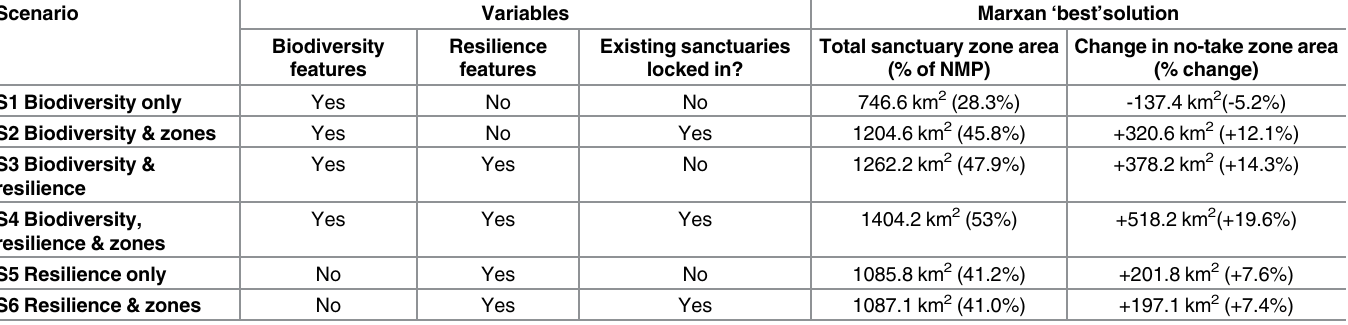
Table 4. Summary of conditions set and Marxan outputs for 6 different scenarios tested where a target of 34% representation for each feature within each scenario was met. Note that the total reserve area of existing sanctuary zones is 884 km 2 (34%) and total area of Ningaloo Marine Park is 2633 km 2